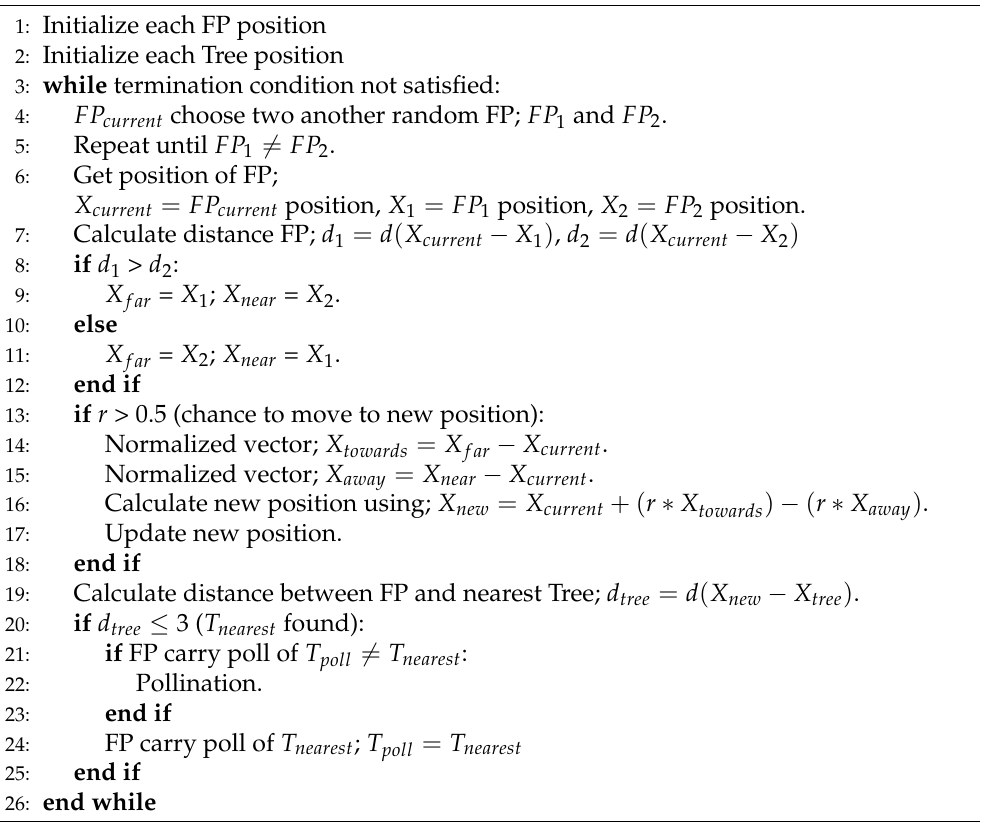
Algorithm 1 The